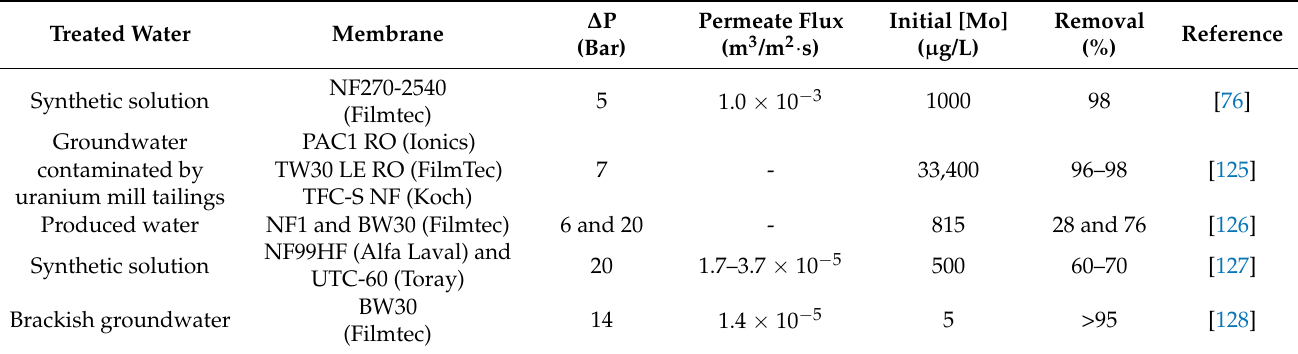
Table 11. Compilation of the main results of the membrane technologies applied for molybdenum removal from aqueous